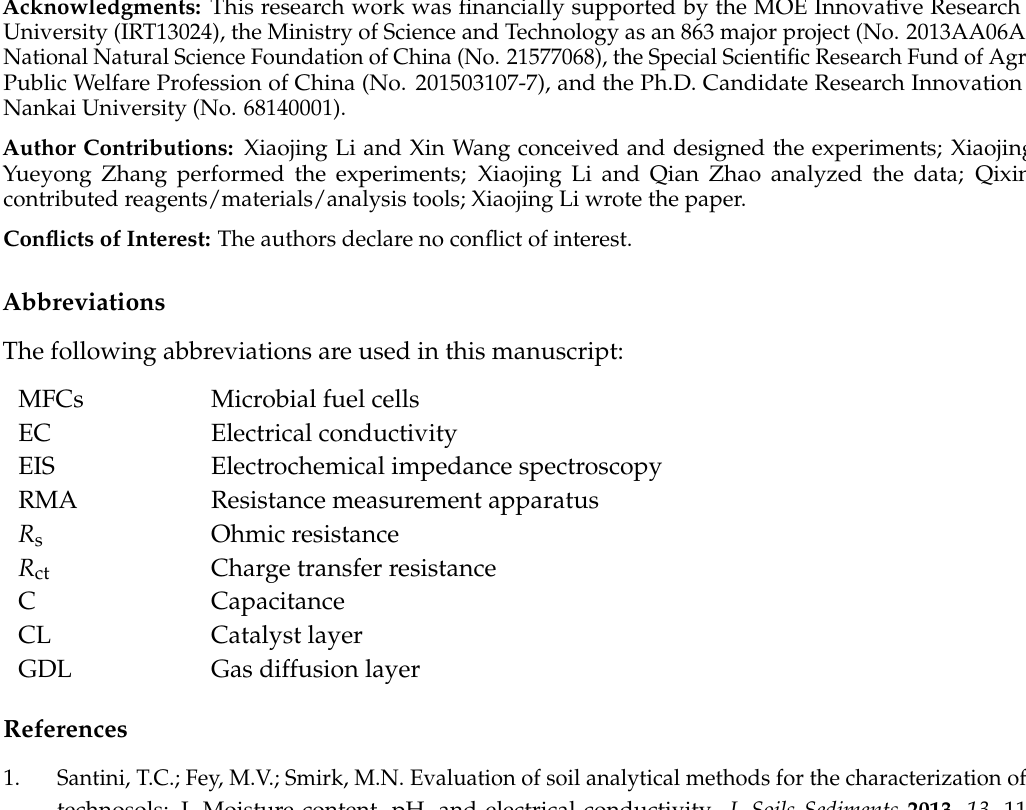
Figure S1: Duplicate measurement of samples showed in Figure 2, Table S1: R s , R ct and capacitance of duplicate measurements shown in Table 2. Acknowledgments: This research work was financially supported by the MOE Innovative Research Team in University (IRT13024), the Ministry of Science and Technology as an 863 major project (No. 2013AA06A205), the National Natural Science Foundation of China (No. 21577068), the Special Scientific Research Fund of Agricultural Public Welfare Profession of China (No. 201503107-7), and the Ph.D. Candidate Research Innovation Fund of Nankai University (No.